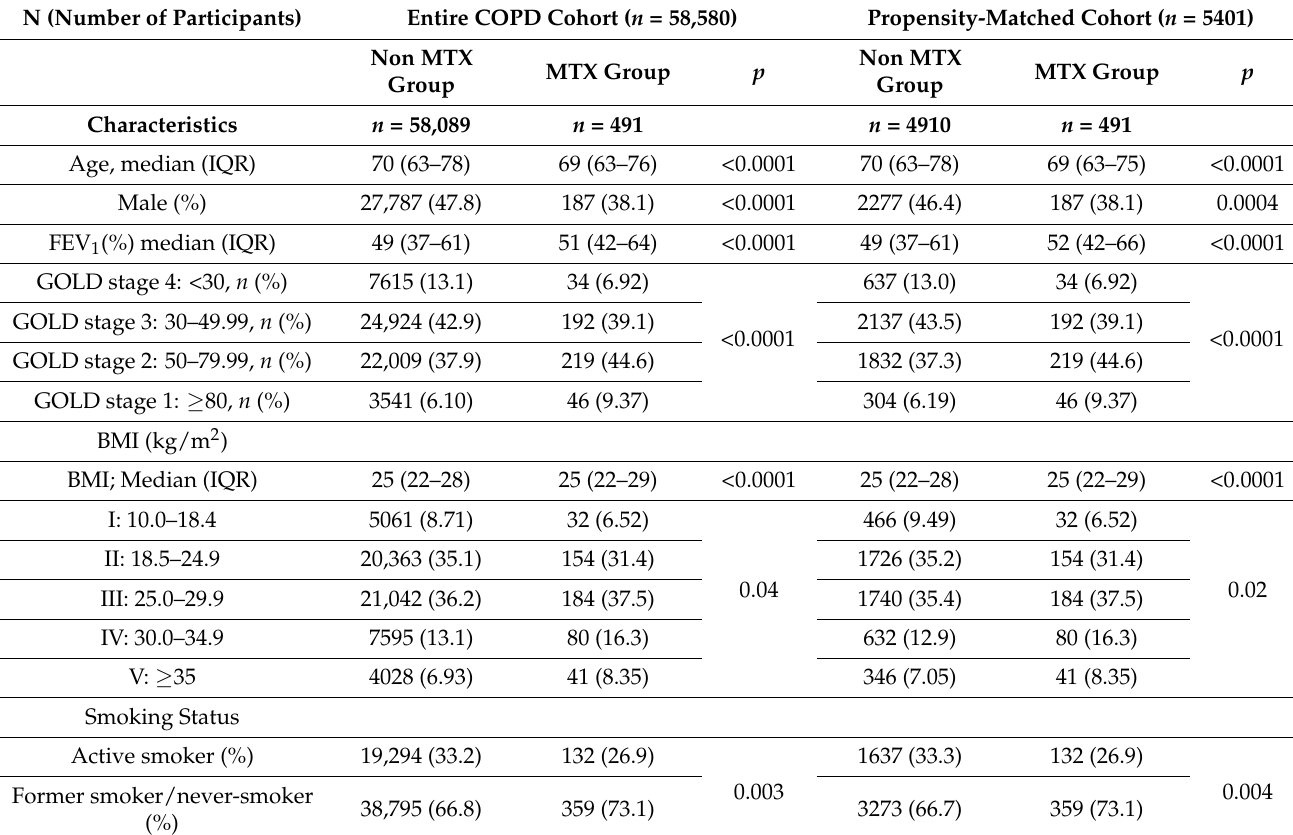
Table 1. The demographic and clinical characteristics of our study